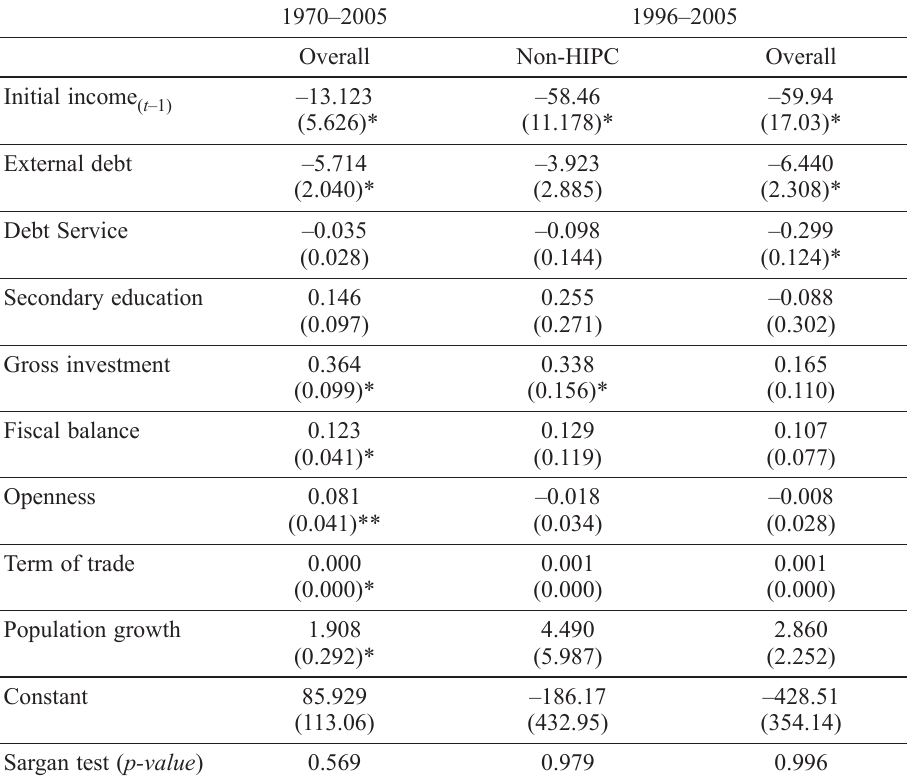
Table 1. Debt-growth nexus in developing